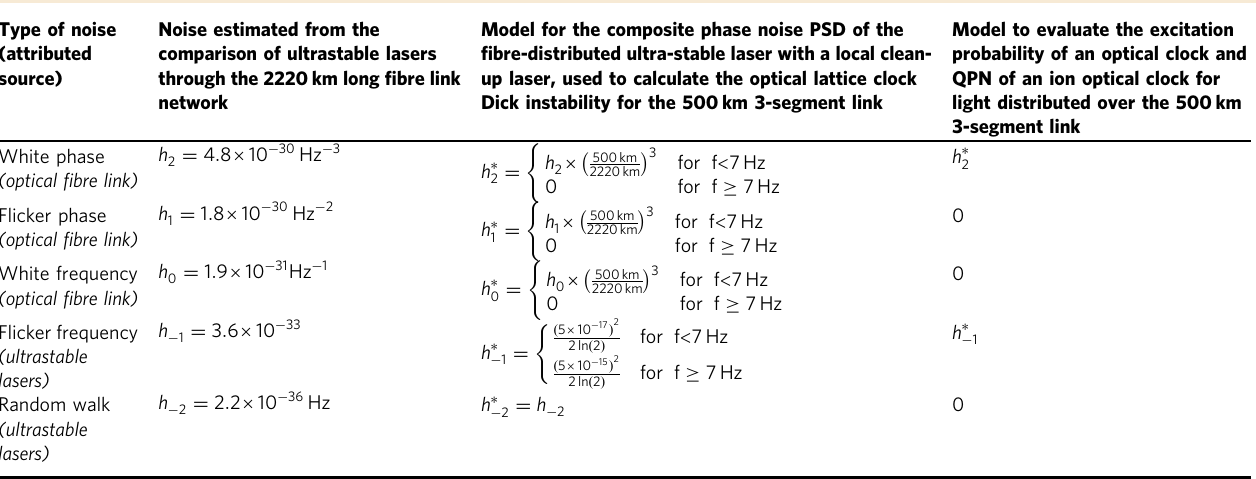
The noise measured in the comparison of ultrastable lasers is expressed in terms of fundamental noise types ( h m ). We derive a simpli fi ed noise model ( h (cid:6) m ) obtained by referencing a local medium- stability laser at 5 ´ 10 (cid:2) 15 to a distant ultrastable laser at 5 ´ 10 (cid:2) 17 delivered through a 500km 3-segment link, under the assumption of dominant delay-unsuppressed link noise 36 , following σ 2 link / L 3 link , with σ link and L link the residual instability and length of the link, respectively. The 500km 3-segment link is equivalent to a 240 km 1-segment link in the approximation of delay-unsuppressed and uncorrelated segment link noise. The parameters for the shorter link are used to evaluate the impact of referencing a local laser to a distant ultrastable laser in terms of reduction of the Dick noise instabilityinalocalopticalclock.Forsimplicity,onlythedominantlinkwhitephasenoiseandlaser fl ickerfrequencynoiseparametersareconsideredtoevaluatetheimprovementinexcitationprobability and QPN instability of a local optical interrogation time T from 150 ms to beyond 1 s leading to a Rabi